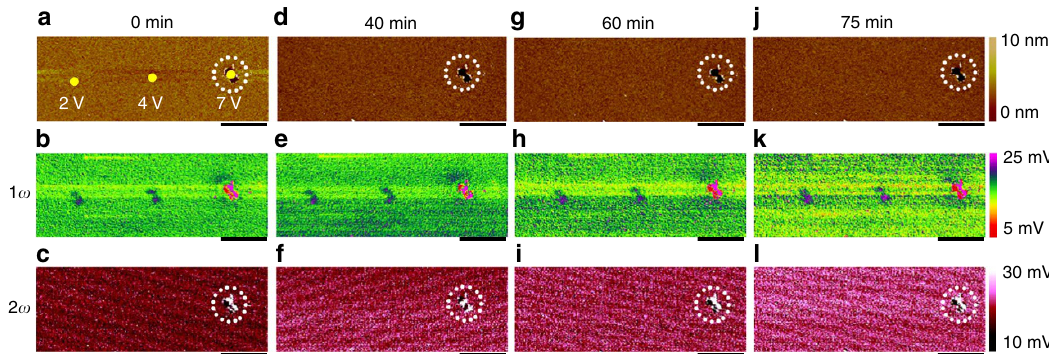
Figure 2 | Retention test of the accumulated charges implying ionic nature. Topographic and EFM results 0min ( a – c ), 40min ( d – f ), 60min ( g – i ) and 75min ( j – l ) after removing the electrical stimuli, showing long retention of the charges. Scale bar, 3 m m. This suggests that the charges observed in the 1 o component of the electrostatic force gradient should correspond to oxygen ions, instead of